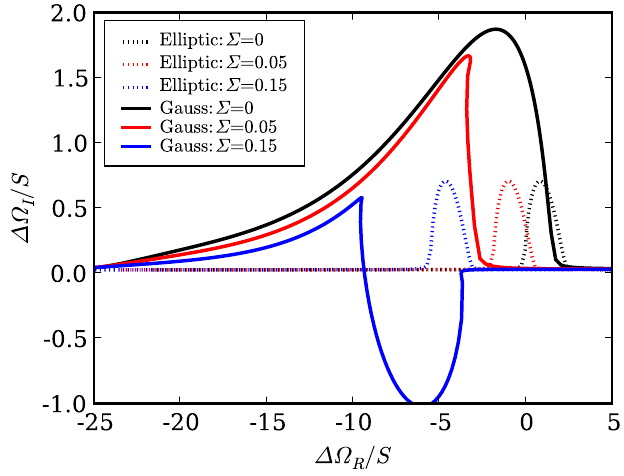
FIG. 4. (Color) Stability boundaries from Eq. (28) as a function of the normalized coherent frequency shifts for different space charge parameters in a single rf wave. The bunch length of the equivalent Gaussian and elliptic distributions is (cid:1)